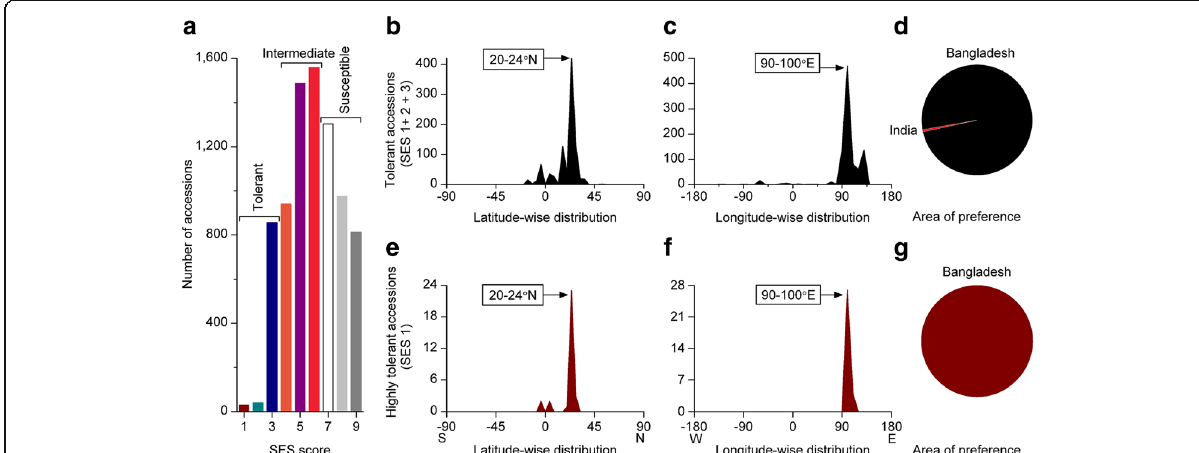
Fig. 1 Geographic distribution pattern of salt tolerant rice accessions. a Extent of salt tolerant accessions, b - d Geographic distribution pattern of salt tolerant (SES score 1-3) accessions, b Latitude-wise distribution, c Longitude-wide distribution, d Area of preference, e - g Geographic distribution pattern of highly salt tolerant (SES score 1) accessions, e Latitude-wise distribution, f Longitude-wide distribution, g Area of preference. Screening results of all abiotic stress tolerance were collected from the International Rice Genebank Collection Information System (IRGCIS 2017). Geo-tagging information of the tolerant and highly tolerant accessions were plotted for latitude- and longitude-wise distribution of 4° and 10° band, respectively. The area of preference was identified based on the prevalence of tolerant or highly tolerant accessions within the preferred latitude and longitude. List of highly tolerant accessions can be found in Additional file 4: Table